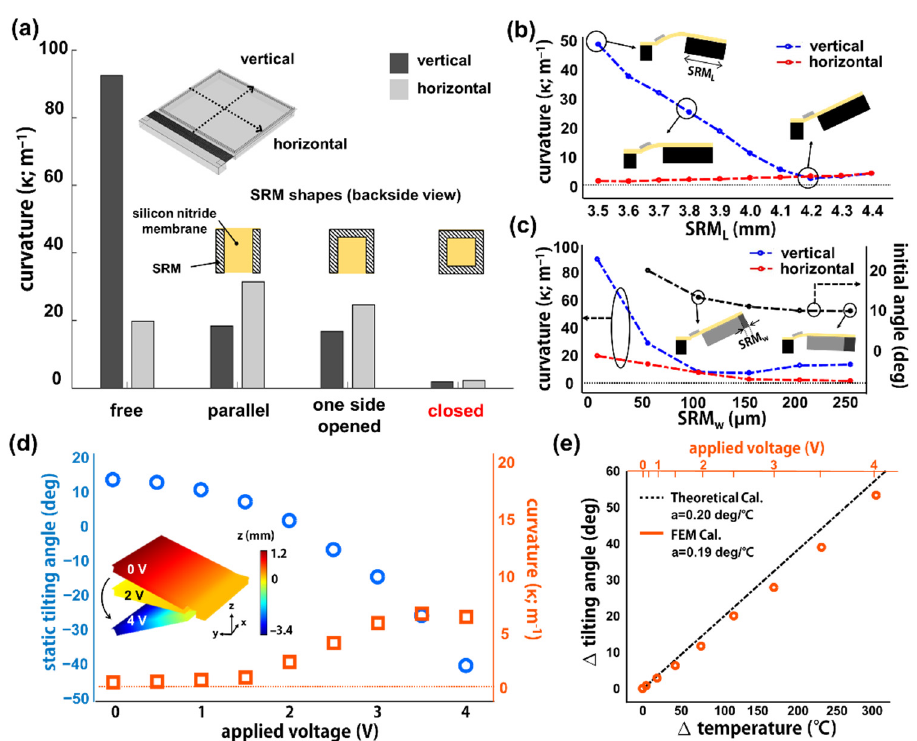
Figure 2. Numerical analysis on the film flatness and electrothermal actuation of SRM-mirror. Calculated curvatures of SRM-mirror depending on ( a ) the shape, ( b ) length, and ( c ) width of silicon rims. ( d ) Tilting angles and film curvatures of SRM-mirror during electrothermal actuation with voltages increasing from 0 V DC to 4 V DC . ( e ) Comparison of FEM calculation with theoretical calculation.